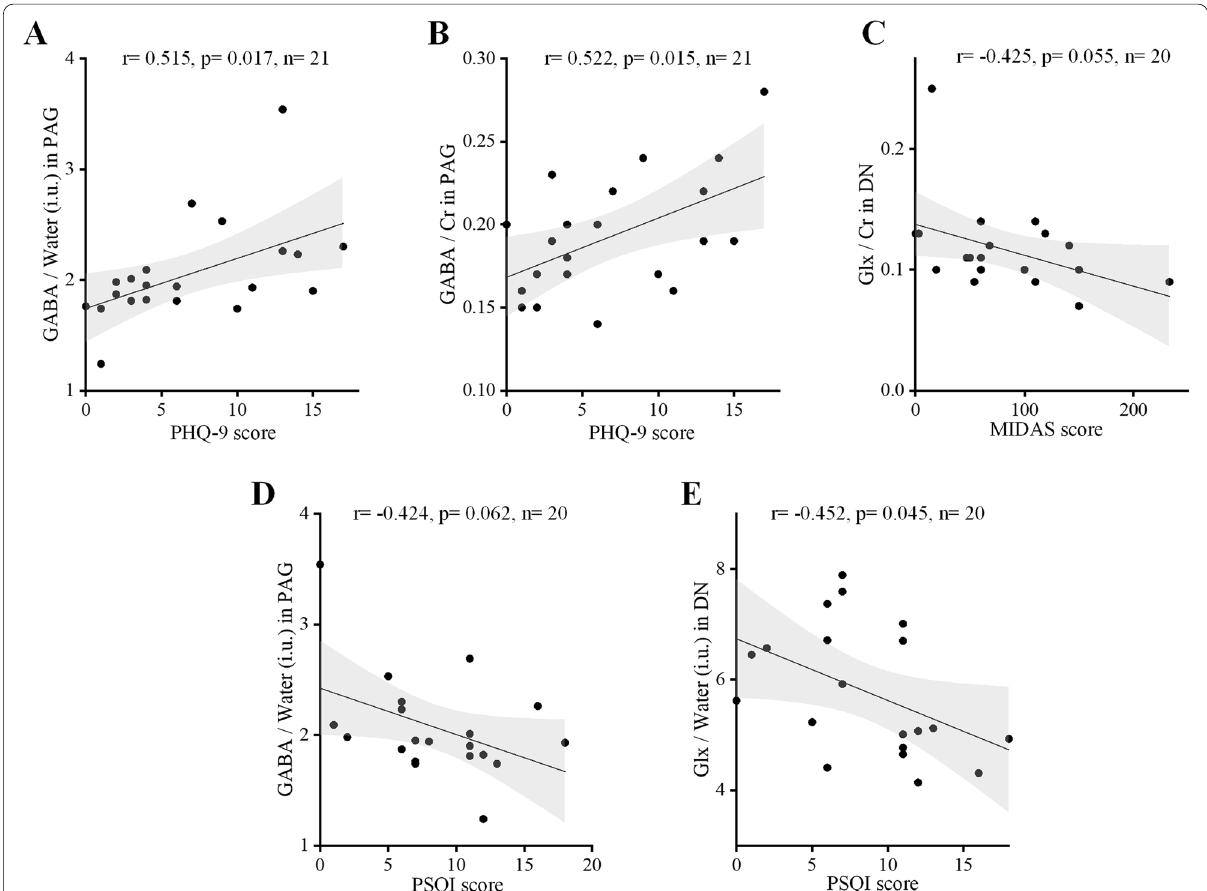
Fig. 5 Associations between migraine characteristics and neurochemical levels. a Positive correlation between GABA/water in the PAG and the PHQ-9 score ( r 0.515, p 0.017, n 21). b Positive correlation between GABA/Cr in the PAG and the PHQ-9 score ( r 0.522, p 0.015, n 21). c = = = = = = Negative correlation between Glx/Cr in the DN and the MIDAS score ( r -0.425, p 0.055, n 20). d Negative correlation between GABA/water = = = in the PAG and the PSQI score ( r -0.424, p 0.062, n 20). E Negative correlation between Glx/Water in the DN and the PSQI score ( r -0.452, = = = = p 0.045, n 20). Dots represent participants with migraine. The black regression line represents Pearson’s correlation coefficient (r). Gray shading = = represents the 95% confidence intervals of the partial correlations. Abbreviations: PAG, periaqueductal gray; DN, dentate nucleus; Cr, creatine; GABA, gamma-aminobutyric acid; Glx, glutamate/glutamine; MIDAS, migraine disability assessment scale; PHQ-9, Patient Health Questionnaire-9;